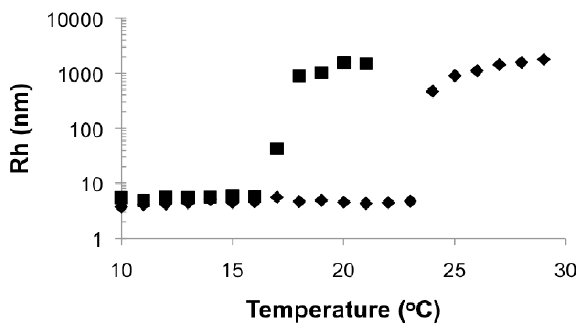
Figure 9. Hydrodynamic radii of particles (R poly(DMAEMA- stat -styrene) with 96 mol% DMAEMA (DMAEMA/S-95/5, (cid:132) ) and 89 mol% DMAEMA (DMAEMA/S-90/10, (cid:139) ) in pH 10 buffer solution at 0.5 wt%